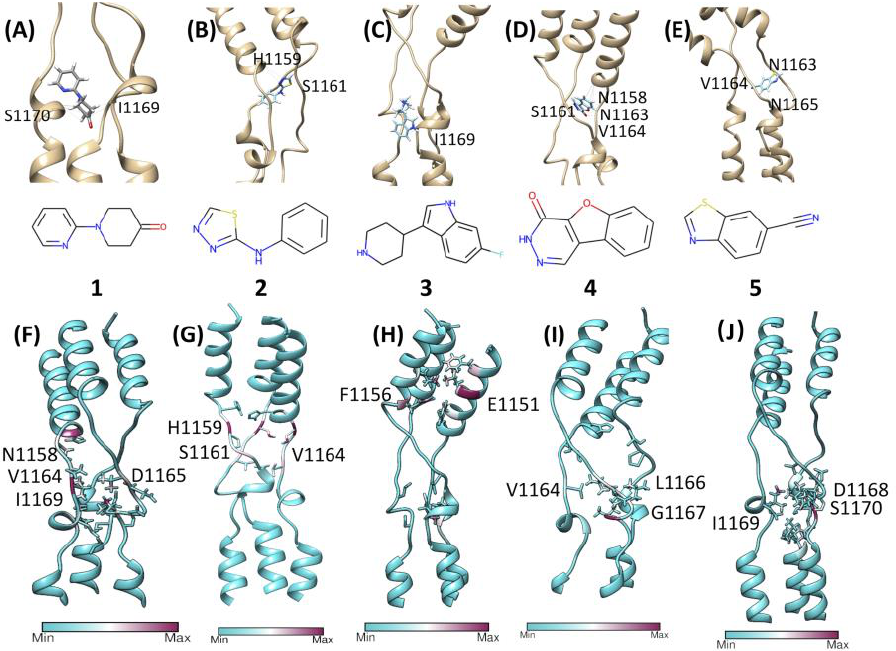
Figure 4. ( A – E ) The best five fragments (1 – 5) according to molecular docking followed by 10 ns of post-docking cMD simulations; the final conformation (stick representation) after 10 ns is reported.